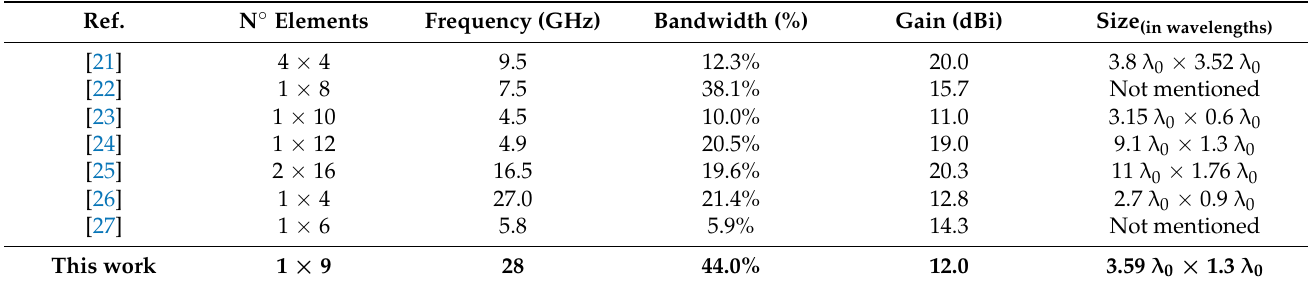
Table 4. Comparison between the different series-fed array